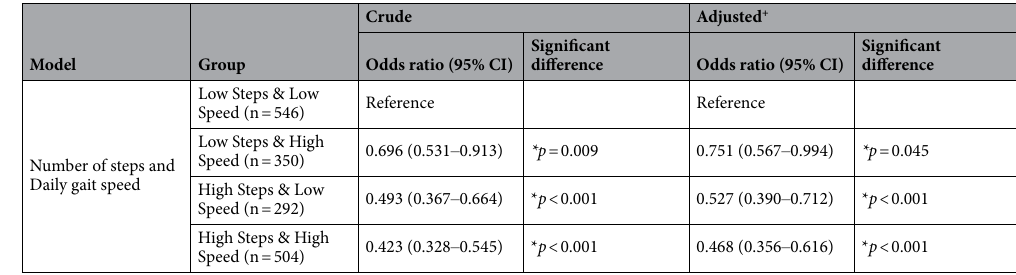
Table 4. Association of combined number of steps and daily gait speed with prefrailty in the binomial logistic regression models. + Adjusted variables were age, sex, and body mass index (BMI). CI = confidence interval; * p < 0.05. Low Steps & Low Speed: Participants with a number of steps of < 6,342.2 steps/day and daily gait speed < 106.3 cm/s. Low Steps & High Speed: Participants with a number of steps of < 6,342.2 steps/day and daily gait speed ≥ 106.3 cm/s. High Steps & Low Speed: Participants with a number of steps of ≥ 6,342.2 steps/ day and daily gait speed < 106.3 cm/s. High Steps & High Speed: Participants with a number of steps ≥ 6342.2 steps/day and daily gait speed ≥ 106.3